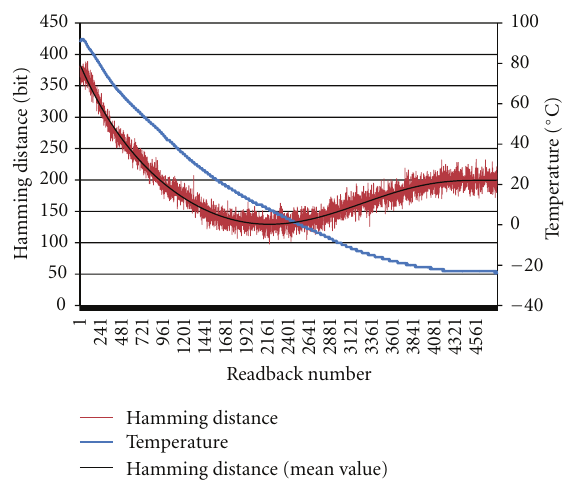
Figure 14: 4800 hamming distance measurements taken during temperature sweep from 85 ◦ C to − 30 ◦ C environmental tempera- ture. The blue curve shows the chip temperature.